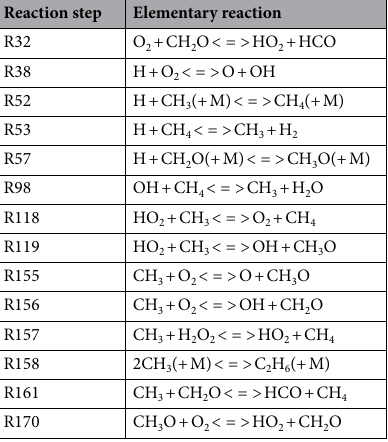
Table 1. Main reactions affecting the change of free radicals.